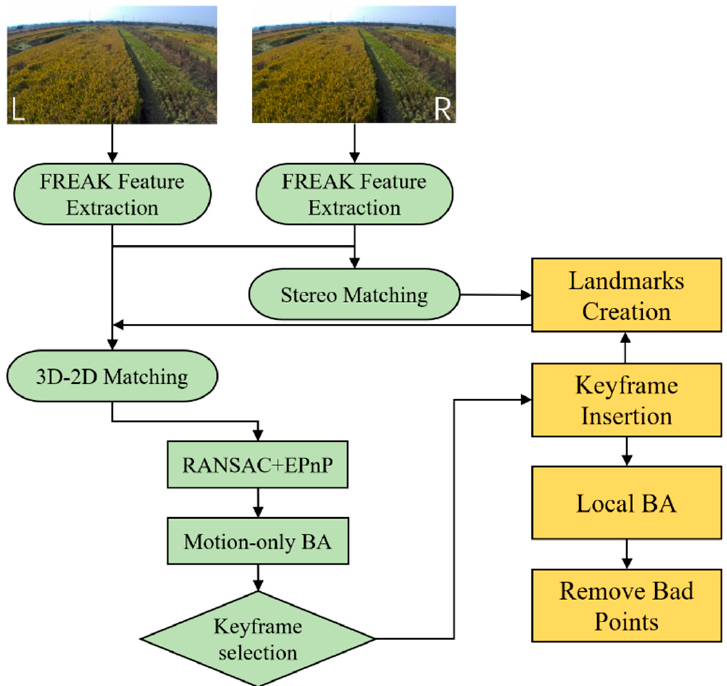
Figure 1. Our method is split into two separate threads, one for estimating the motion of combine harvesters (green block) and the second for optimization (yellow block).